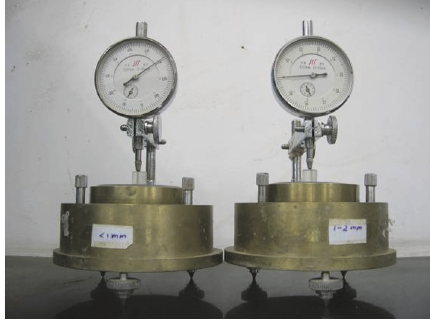
Figure 2: WZ-2 dilatometer used in swelling test.